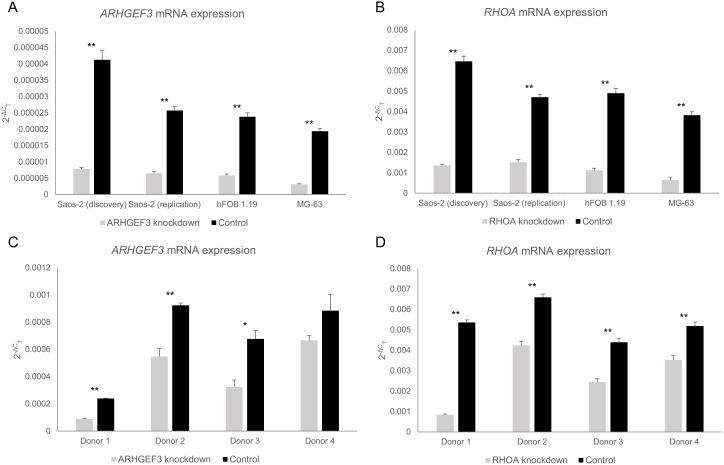
qRT-PCR validation of ARHGEF3 and RHOA gene knockdown in each cell type.(A) ARHGEF3 mRNA expression in osteoblast-like cells. (B) RHOA mRNA expression in osteoblast-like cells. (C) ARHGEF3 mRNA expression in osteoclast-like cells. (D) RHOA mRNA expression in osteoclast-like cells. Data displayed as mean 2−ΔC
T ± SEM from three biological replicates. *P<0.05, **P<0.01.